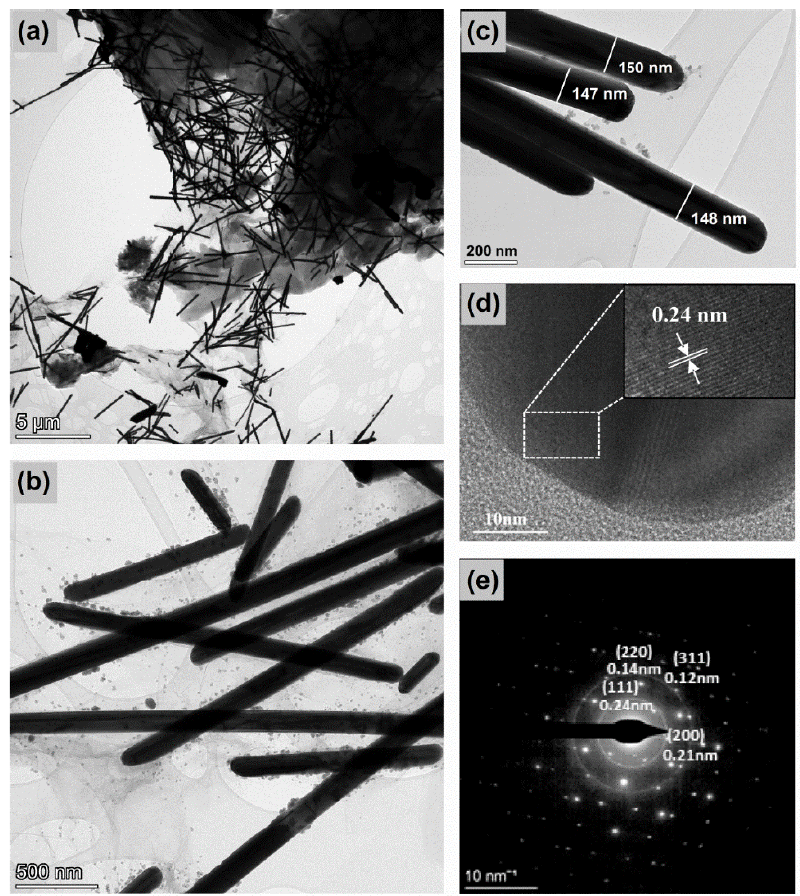
Figure 3. ( a – c ) Representative TEM images of f -rGO DBSA /AgNWs50% system prepared via the in situ method; ( d ) HRTEM of the tip region of a single silver nanowire; ( e ) typical SAED pattern of the tip region.